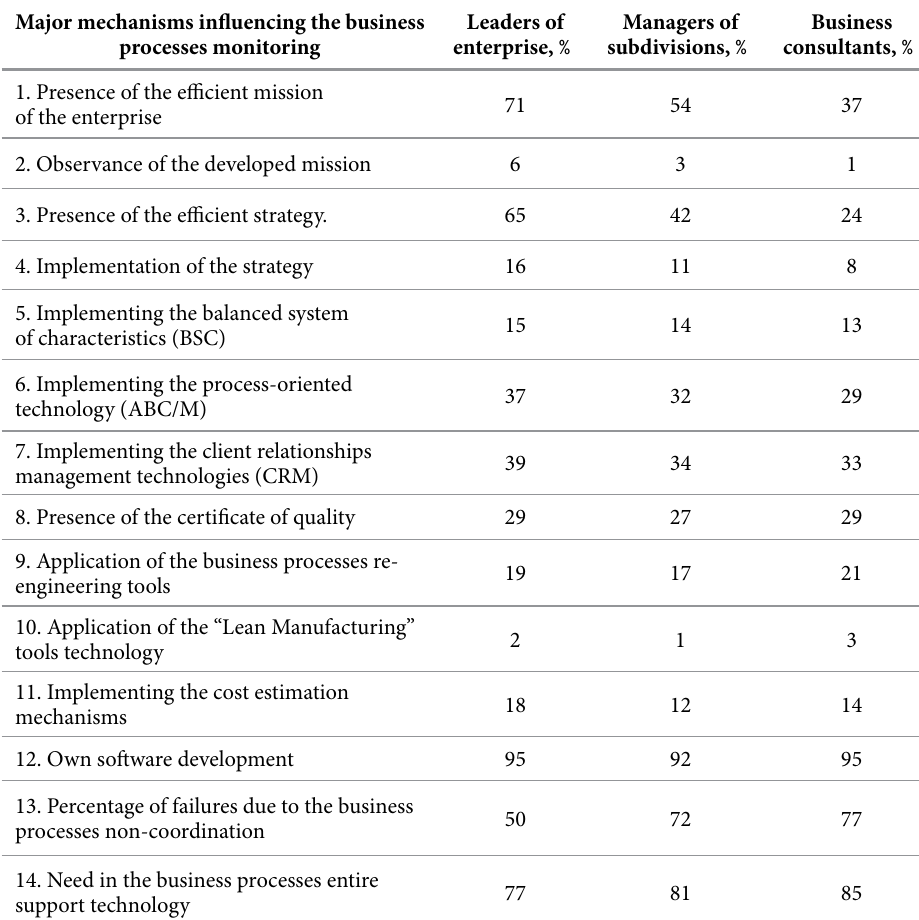
major mechanisms influencing the